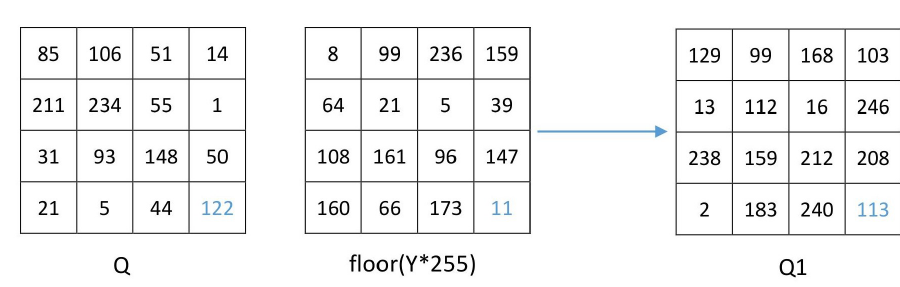
Figure 9. Example of diffusion